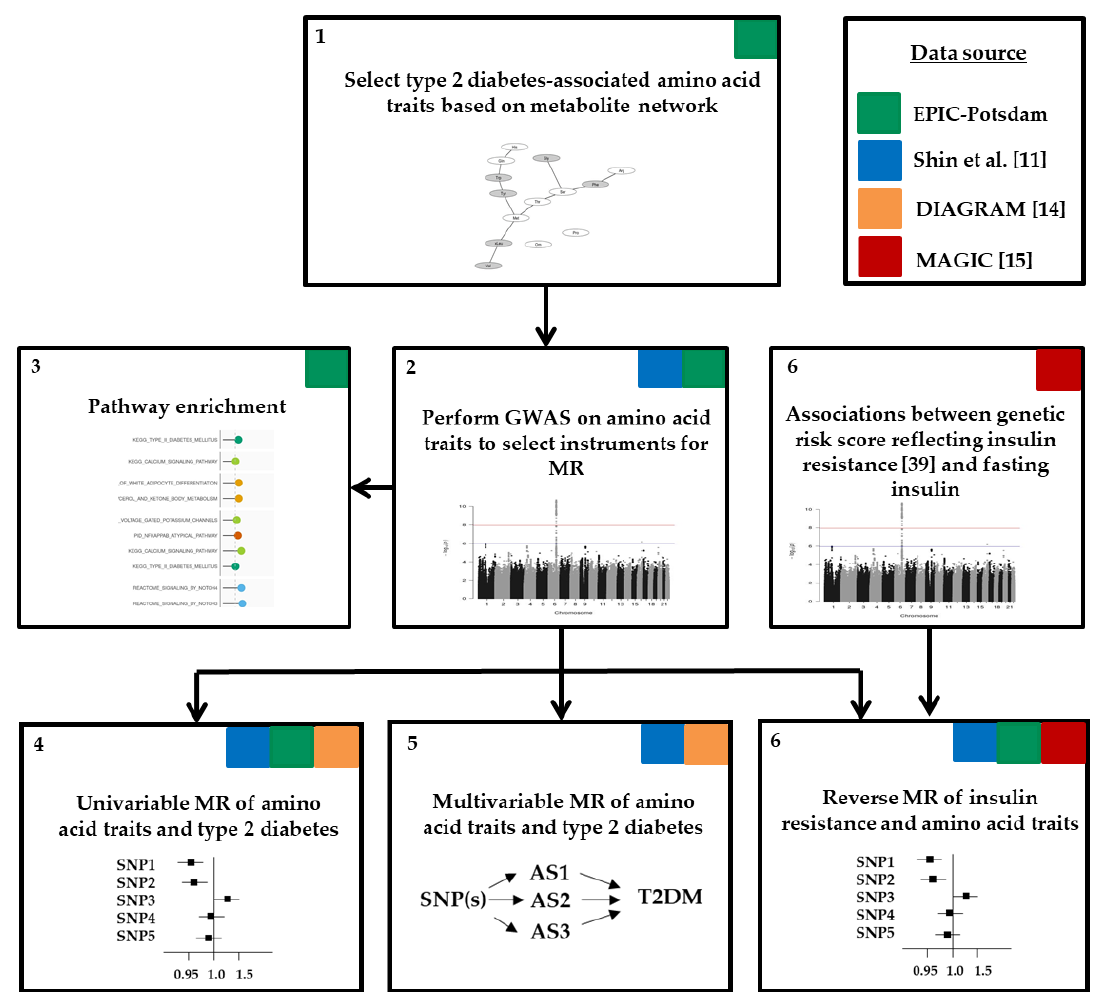
Figure 1. Workflow of analysis. AS, amino acid; DIAGRAM, DIAbetes Genetics Replication And Meta-analysis; GWAS, genome-wide association study; MAGIC, the Meta-Analyses of Glucose and Insulin-related traits Consortium; MR, Mendelian randomization; SNP, single nucleotide polymorphism; T2DM, type 2 diabetes mellitus.